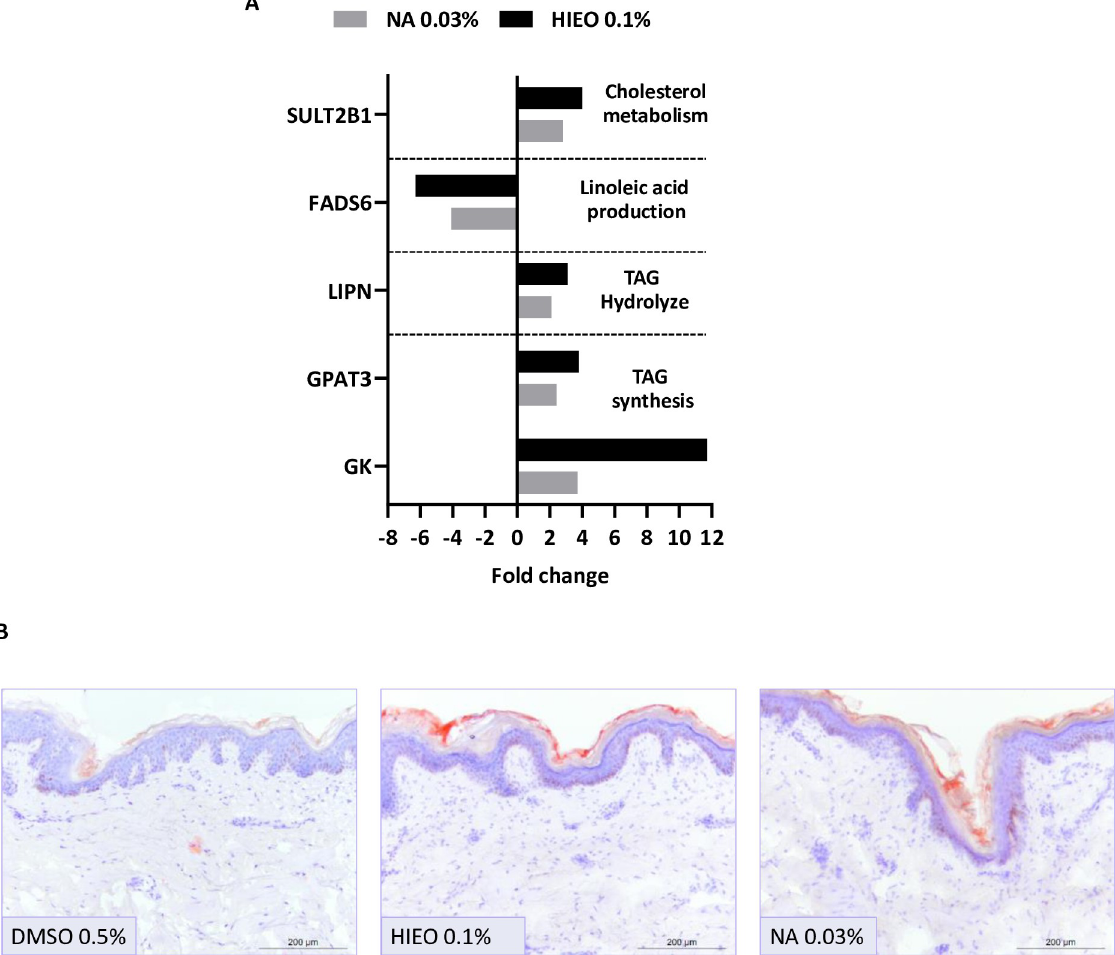
Fig 7. NA increased lipids in the epidermis. A: Transcriptome analysis was performed with microarray using skin explant treated with NA (0.03%) or HIEO (0.1%) and a control group, DMSO (0.5%). Mean fold-change induced by HIEO and NA in quadruplicate explant for each donor from three distinct donors after 24-hour treatment are shown. The 1008 genes in common to HIEO and NA were analyzed with IPA software and an enrichment analysis of certain pathways allowed the identification of differentially expressed genes (fold changes � 2 or � -2, FDR p-value < 0.05) involves TAG synthesis, linoleic acid synthesis and cholesterol metabolism. Mean fold-changes induced by HIEO and NA (NA) in quadruplicate explant for each donor from three distinct donors after 24-hour treatment are shown. B: Skin sections were stained with Oil Red O to detect neutral lipid in the epidermis at day 5 after DMSO 0.5%, NA 0.03% or HIEO 0.1% treatment. Optical representative images show the location of dye in the intercellular spaces of the epidermis. Lipids are stained in red. Scale bar, 200 μ